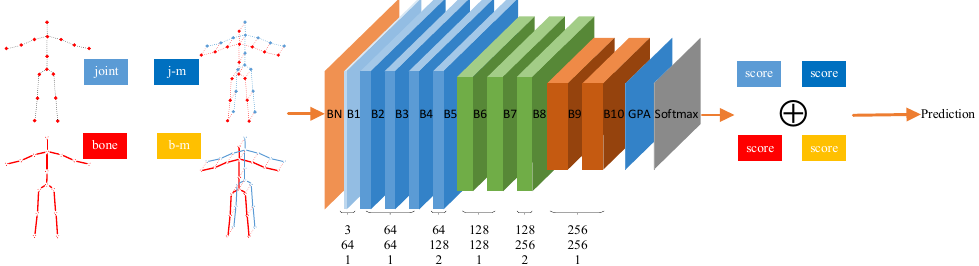
Figure 1. The architecture of the enhanced spatial and extended temporal graph convolutional network. There are a total of 10 basic blocks in the network, which are marked as B1 to B10. Take B8 as an example to introduce the meaning of the three numbers (i.e., 128, 256, 2) below each block. The number of input channels and output channels of B8 is set to 128 and 256, and the temporal stride is set to 2. There are four modalities fed into the network separately: joint, bone, joint motion (j-m), and bone motion (b-m). The corresponding four softmax scores are added to get the final prediction results.